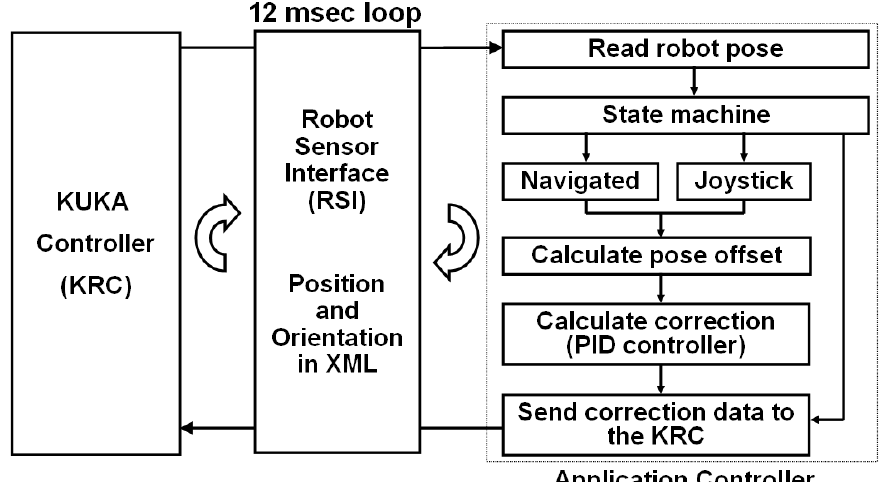
Figure 7. Control loop to manipulate the robot pose in the application